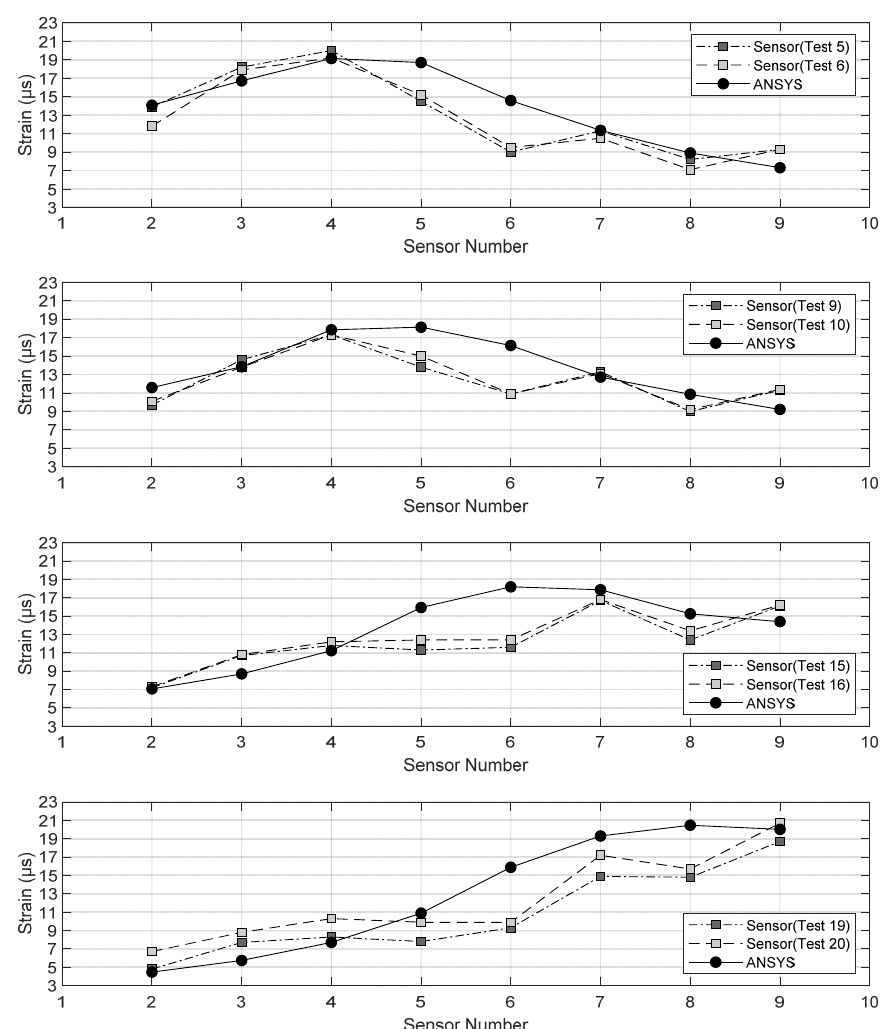
Figure 8. Numerical and empirical strains measured at given gauge locations when the static load (truck with certified weight) was applied to certain locations above span 1.